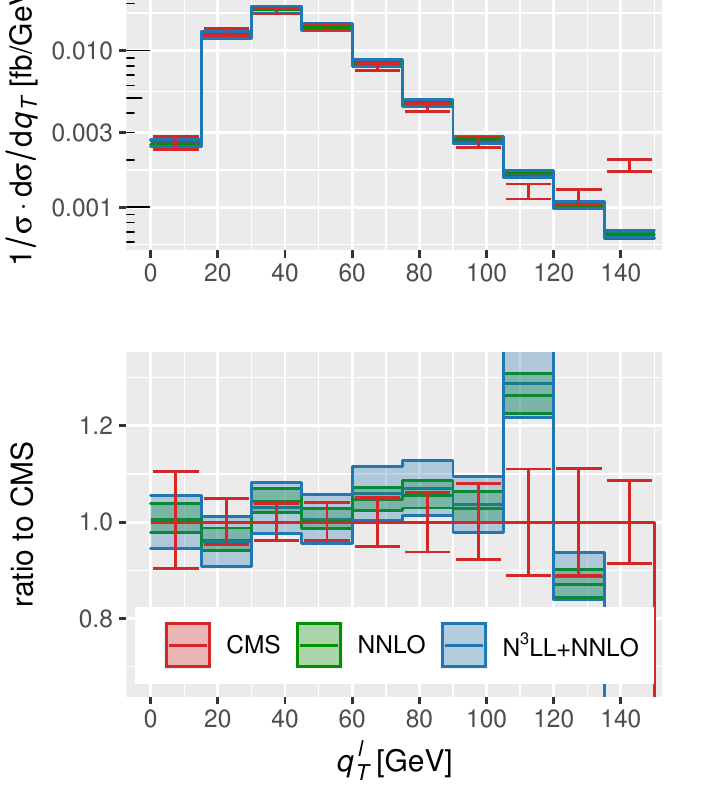
Figure 3 . The q l (summed over all leptons) distribution at NNLO and N 3 LL+NNLO, compared T to the CMS data from ref. [25].